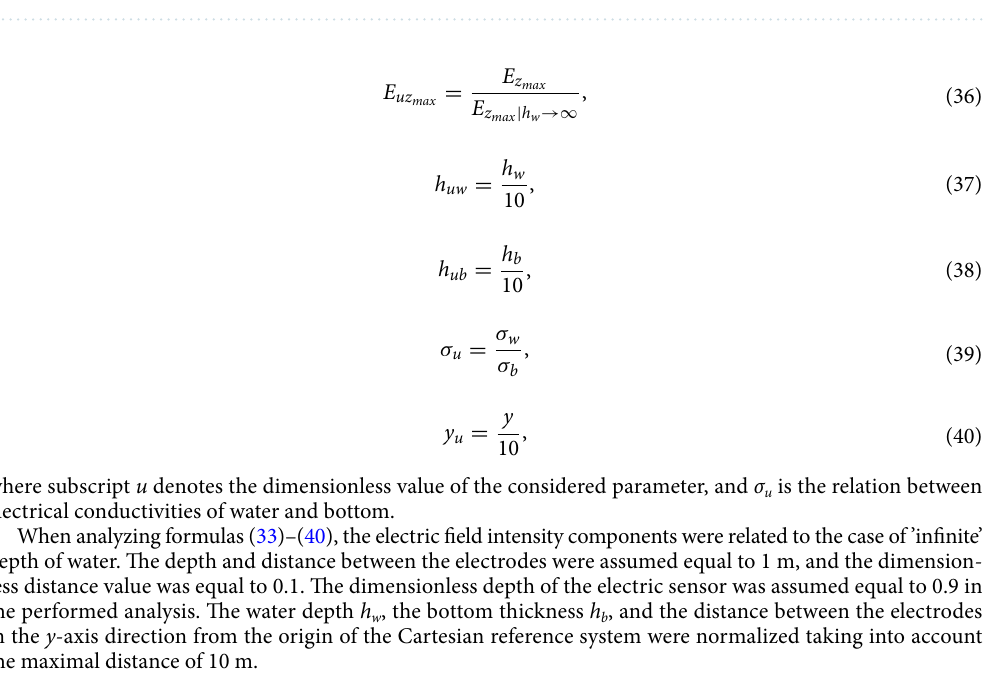
Figure 31. Difference of E x and E z between analytical and Opera solutions for three and four layers (Fig.